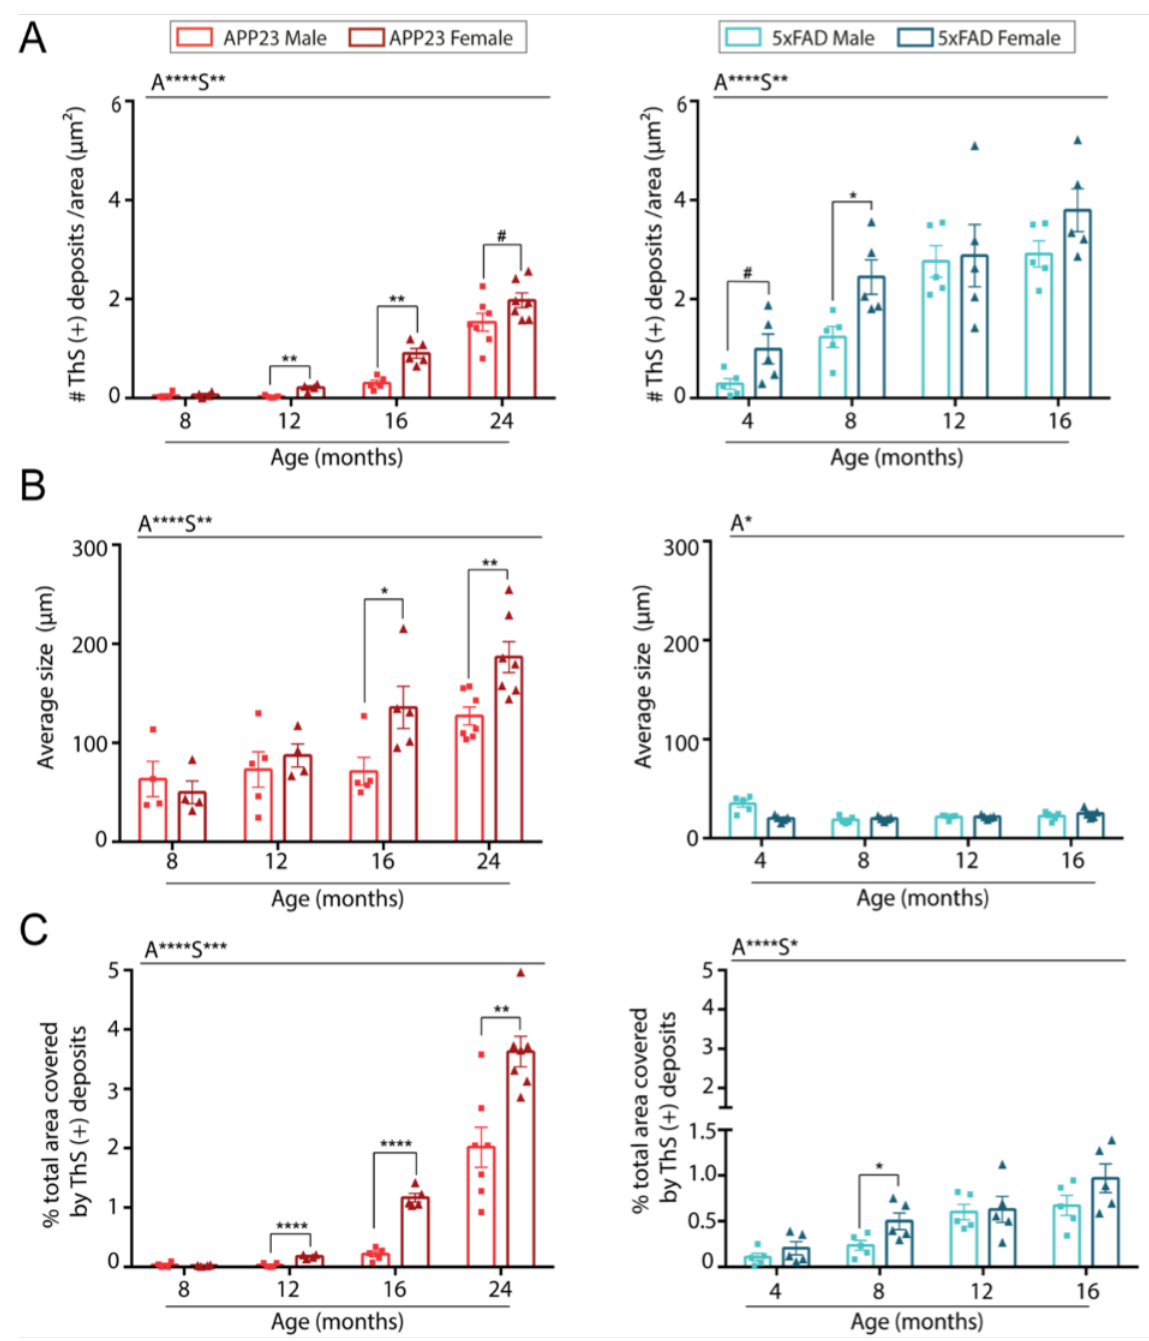
Figure 2. Quantification of parenchymal A β burden in brains from male and female 5xFAD and APP23 mice at different ages. ( A ) Quantification of the number of ThS-positive deposits corrected by area. ( B ) Quantification of the average size of ThS-positive deposits. ( C ) Quantification of total area occupied by the deposits (%). n = 4–7/group. The effect of sex (S) and age (A) was evaluated in each subgroup of data. Statistical differences were analyzed among groups as indicated and represented as: # p < 0.1, * p < 0.05, ** p < 0.01, *** p < 0.001, **** p < 0.0001.